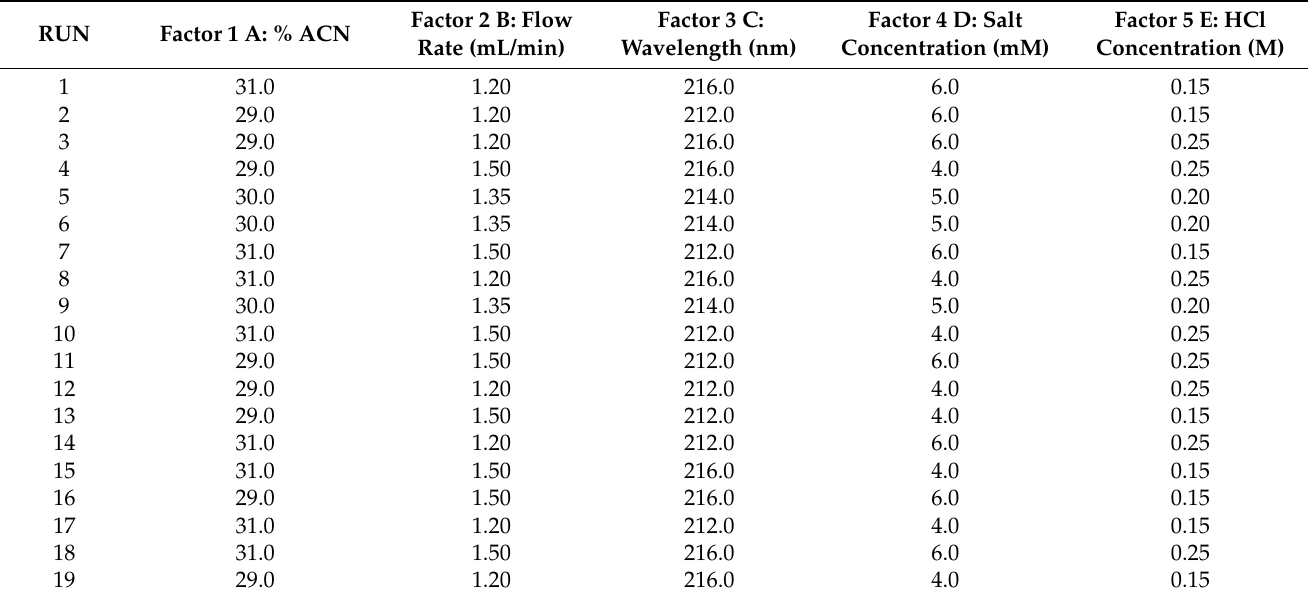
Table 3. The experiments proposed by the software for the fractional factorial